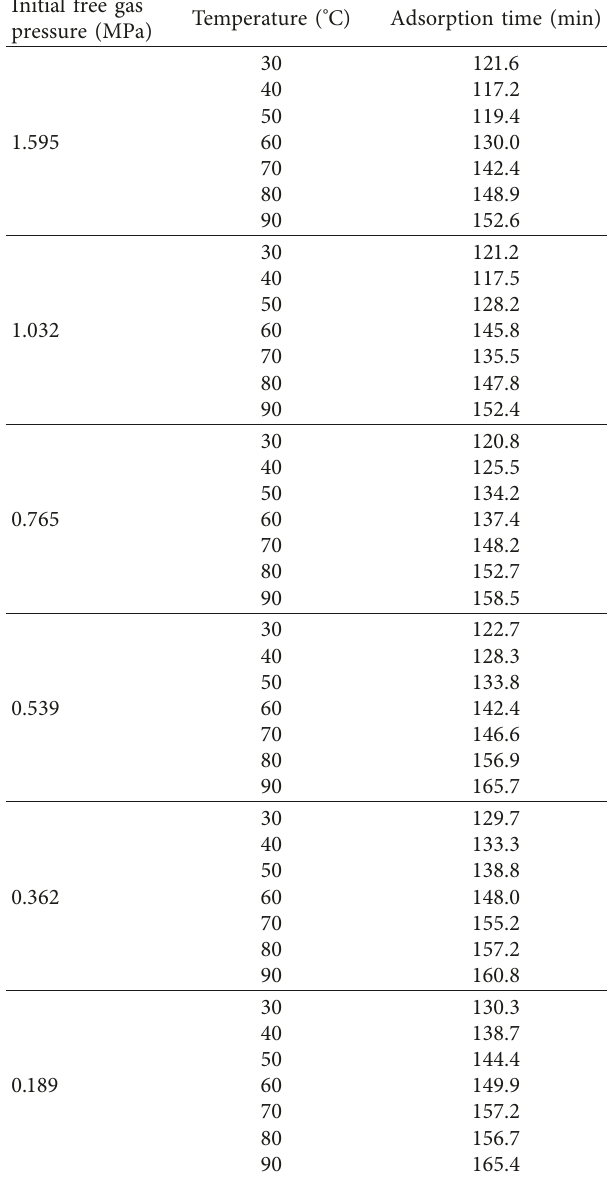
Data Availability Table 5: Desorption time of #2 coal